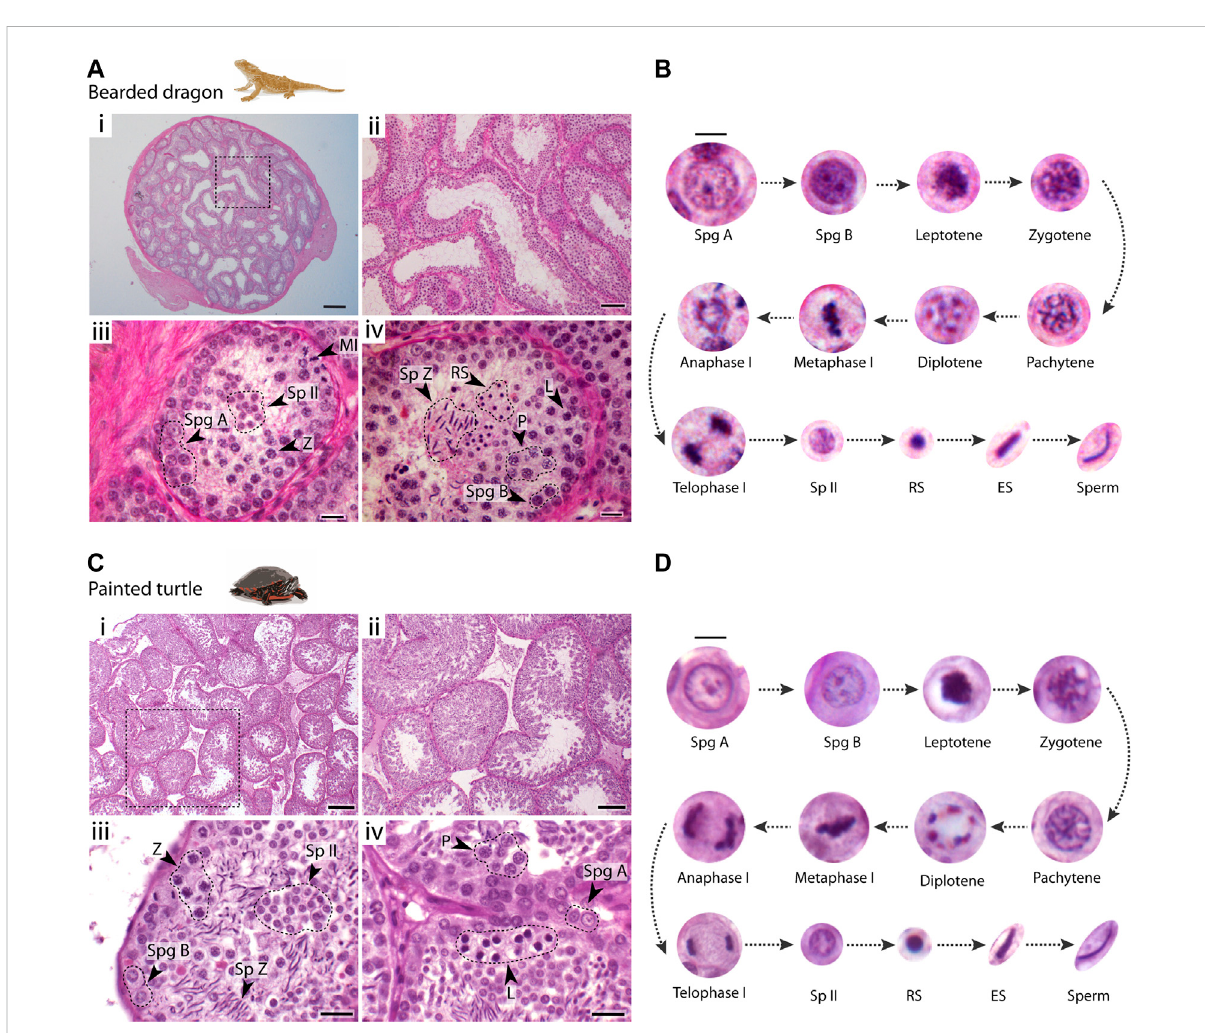
FIGURE 2 Testis histology. Histological cross-sections of seminiferous tubules of (A) the bearded dragon and (C) the painted turtle stained with PAS- hematoxylin. Dashed circles and arrowheads point clusters of different cell types. Scale bars: (i) 200 μ m, (ii) 100 μ m, and (iii, iv) 20 μ m. Germ cell types found within the seminiferous epithelium and their progression in (B) the bearded dragon and (D) the painted turtle. Scale bar: 10 μ m. Legend type: Spg A, type A spermatogonia; Spg B, type B spermatogonia; L, leptotene spermatocyte; Z, zygotene spermatocyte; P, pachytene spermatocyte; D, diplotene spermatocyte; MI, metaphase I; Sp II, secondary spermatocyte; RS, round spermatid; ES, elongating spermatid; Sp Z,